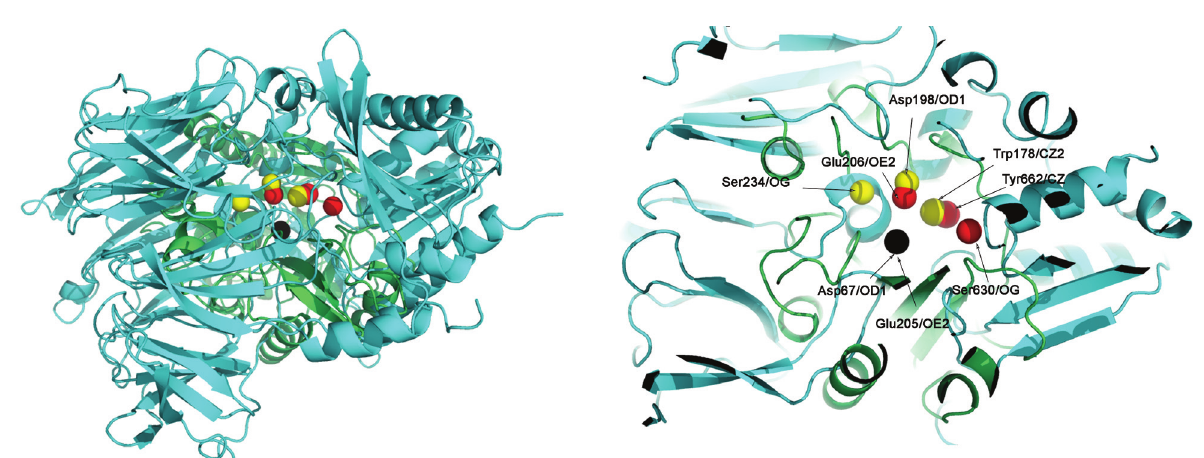
Figure 1. Superimposing PI-PLC (PDBid:3W2TA in green) and DPP4 (PDBid:2OQOA in cyan). Three residues from PI-PLC (Asp67, Asp198 and Trp178 in yellow) were superimposed to the corresponding three residues from DPP4 (Glu205, Glu206 and Tyr662 in red). Asp67OD1 and Glu205OE2 is at the center of the coordinate axis (coordinates = [0,0,0]) (in black), Asp198OD1 and Glu206OE2 lies on the X-Y axis (i.e. Y coordinate is 0) and Tyr662CZ and Trp178CZ2 are on the X-Y plane (i.e. Z coordinate is 0). Asp67, Asp198 and Trp178 in the PI-PLC protein overlaps well with Glu205, Glu206 and Tyr662 from DPP4, but the Ser234-Ser630 pair is not spatially